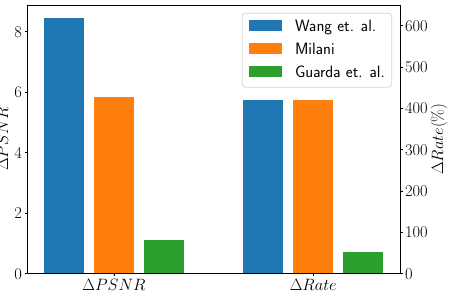
Figure 19. Bjontegard metrics for Wang et al. [107], Milani [106], and Guarda et al. [110] against